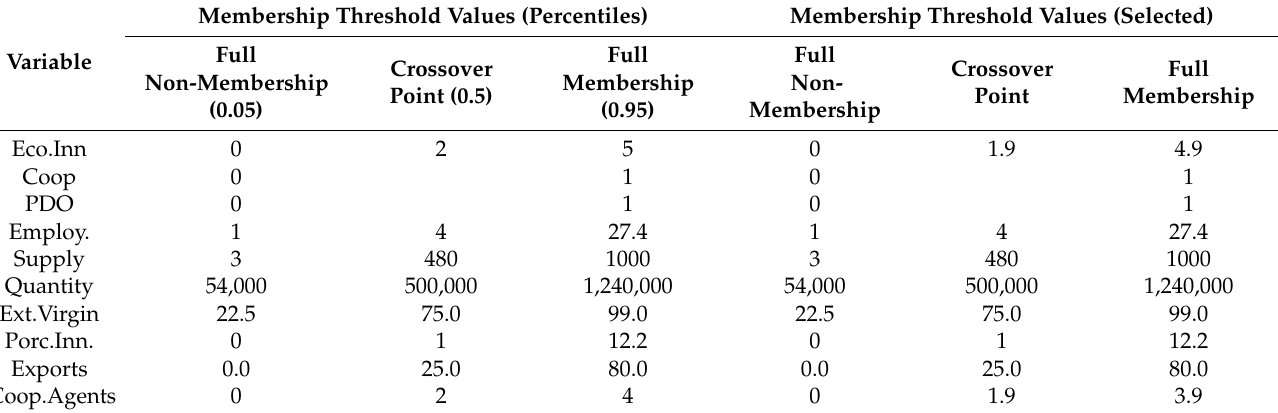
Table 2. Calibration